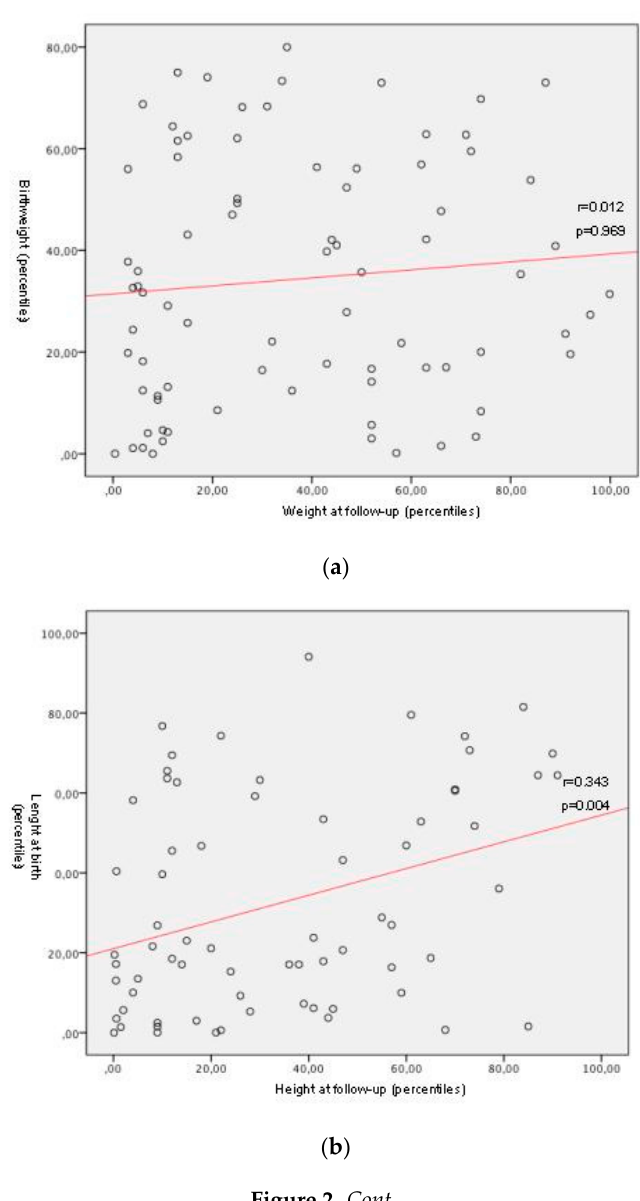
Figure 1. ( a ) Distributions of weight percentiles at birth and at follow-up; ( b ) distributions of length/height percentiles at birth and at follow-up; ( c ) distributions of head circumference percentiles at birth and at follow-up.